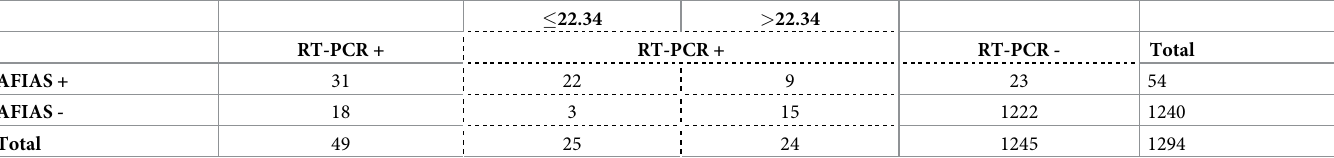
Table 2. AFIAS COVID-19 Ag test sensitivity according to the median RT-PCR Ct value